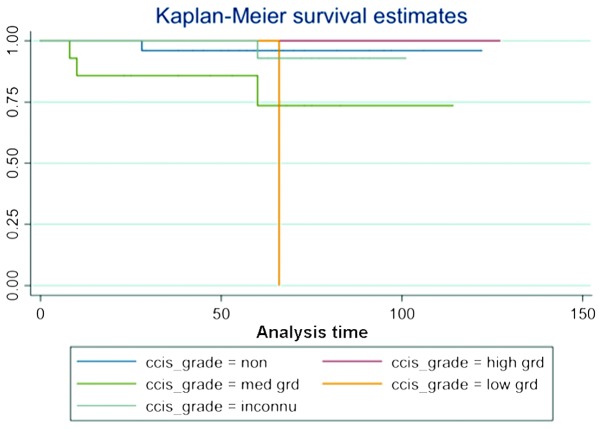
Disease-free survival by satellite lesions presented as ccis associate (Kaplan-Meier). The Kaplan-Meier survival estimates revealed that the lowest degree was considered to be the most important reason for a new occurrence. Among the patients who were detected to have low-grade ductal breast satellite lesions, only one was administered hormone therapy. ccis_grade; grade of microinvasion; non, no micorinvasion; inconnu, unknown.